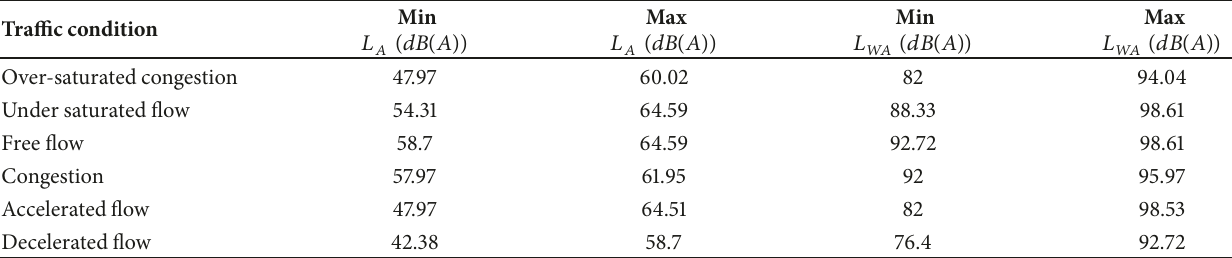
Table 2: Theoretical upper and lower boundaries of traffic noise in different traffic